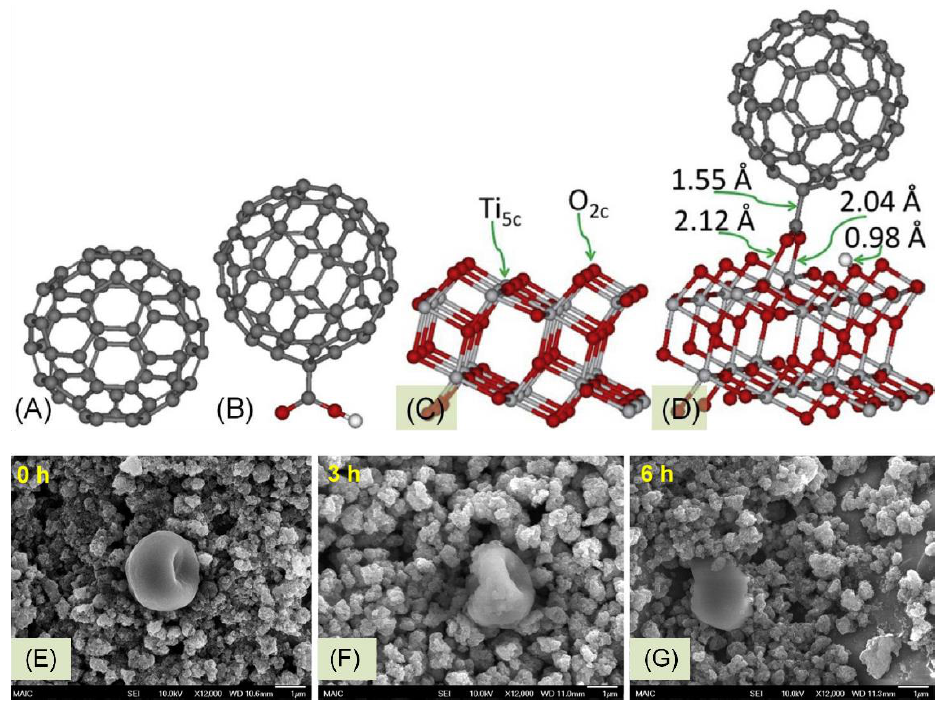
Figure 4. Optimised structures of ( A ) C 60 , ( B ) C 60 -COOH, ( C ) clean a-TiO 2 and ( D ) C 60 -COOH@a-TiO 2 , obtained via DFT computations [96]. Morphological changes in Aspergillus niger spores before inactivation ( E ) and after being inactivated by C 60 /TiO 2 for ( F ) 3 h and ( G ) 6 h, respectively [91].